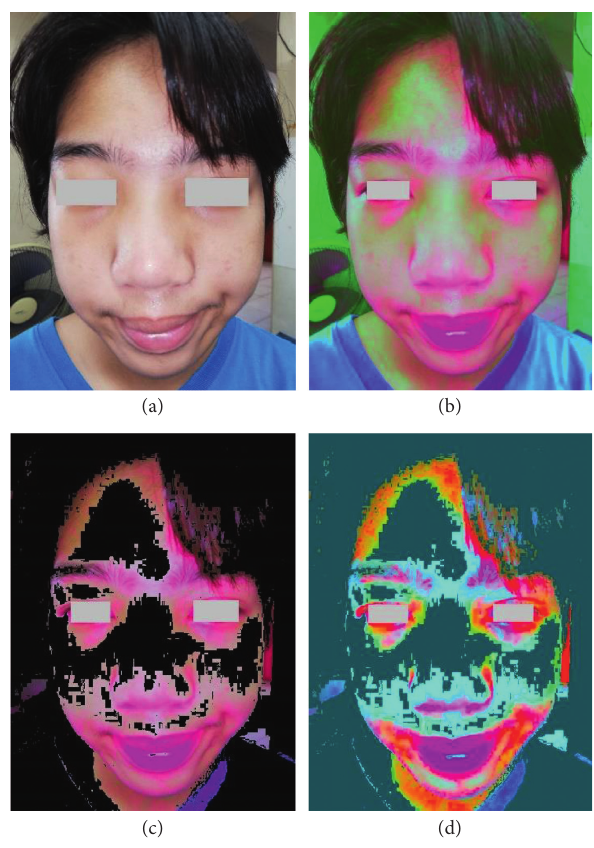
Figure 1: Four steps of the Manote and Matinun (M&M) technique for the 1 st patient. (a) The original photograph by the smartphone camera app revealed invisible facial flushing seen by the naked eye. (b) The 1 st decorrelation stretching picture using the YUV color space. (c) The K-means clustering picture choosing the red cluster. (d) The 2 nd decorrelation stretching picture using the Lab color